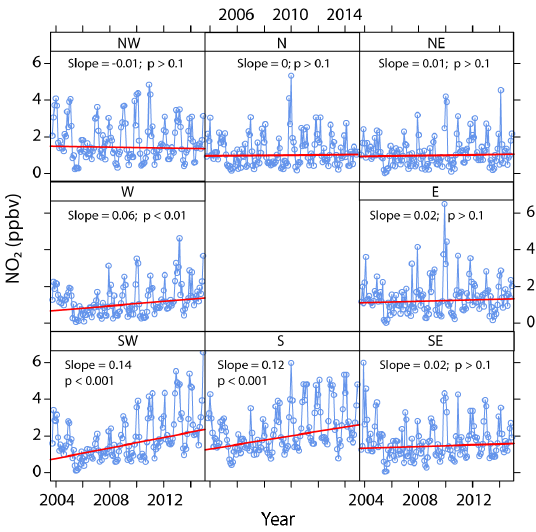
Figure 9. Trends in NO 2 data from Lostwood, segregated by wind direction. Slope is per